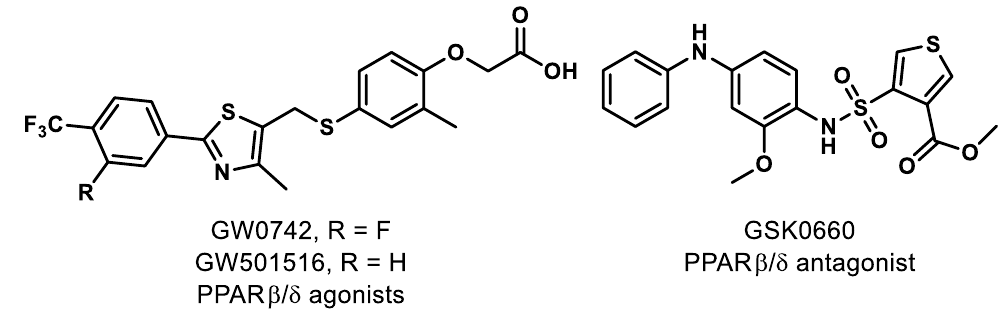
Figure 2. Representative PPARβ/δ modulators.